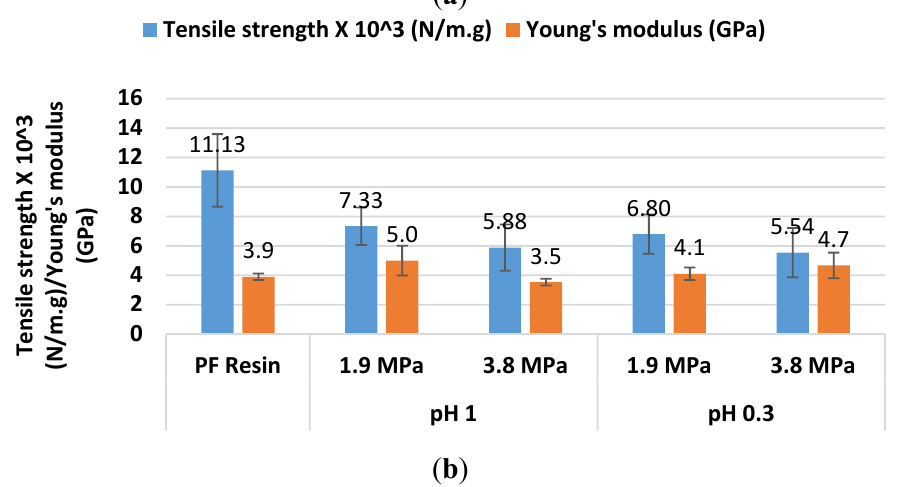
Figure 4. ( a ) Effect of curing temperature (150 °C and 180 °C) on tensile properties of adhesive blends with 5% furfural at curing pressure of 1.9 MPa and reaction pH = 0.3 and 1. ( b ) Effect of curing pressure (1.9 MPa and 3.8 MPa) on tensile properties of adhesive blends with 5% furfural at curing temperature of 180 °C and reaction pH = 0.3 and 1. All samples are compared to PF resin which was cured at 180 °C and 1.9 MPa. Tensile strength per gram (N/m·g) was determined using Equation